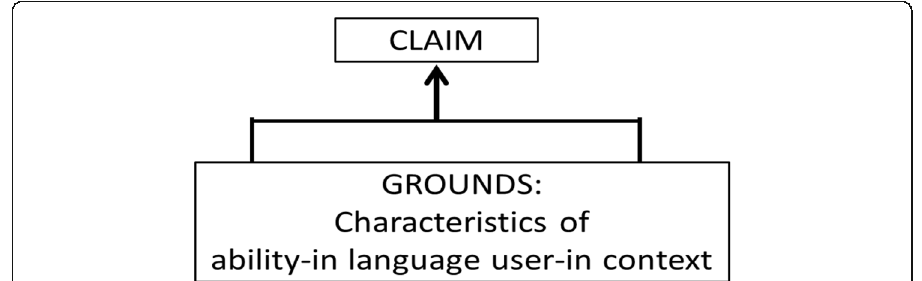
Fig. 5 An integrated inference perspective, framed as ability-in language user-in context from Schwabe et al.